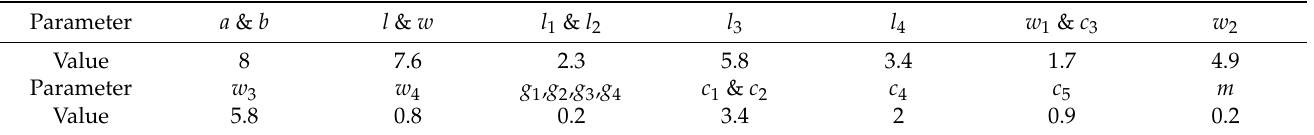
Table 1. Proposed unit cell parameters